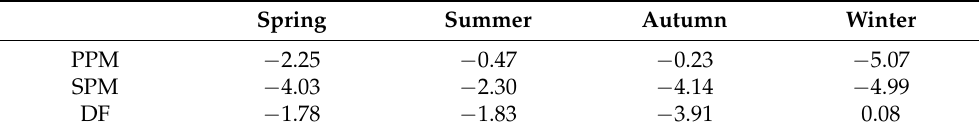
Table 5. Linear trends ( µ g · m − 3 a − 1 ) of PPM and SPM with their differences (DF) in different seasons over